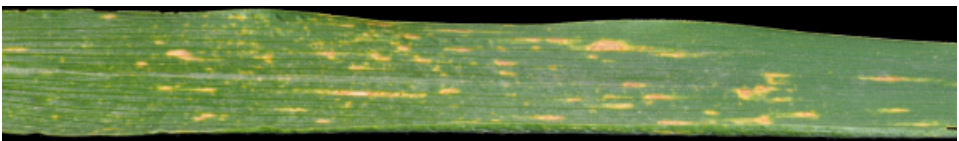
Figure 5. Low-resolution image.